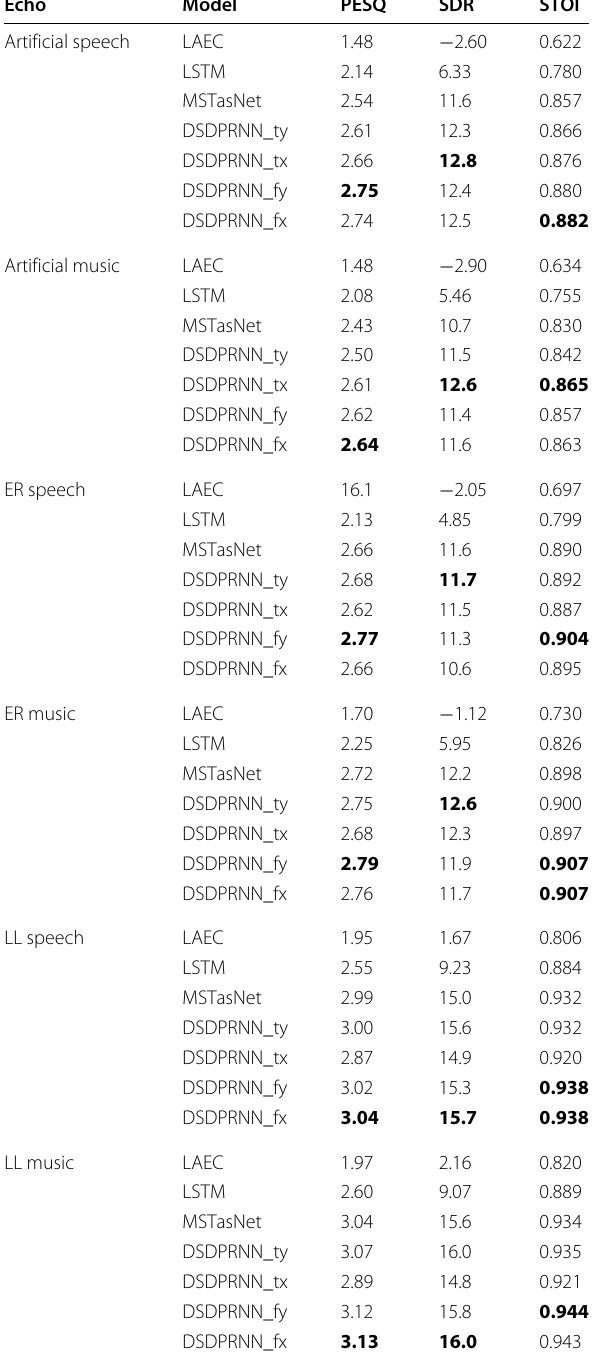
Table 2 Performance of our proposed methods and several typical RES